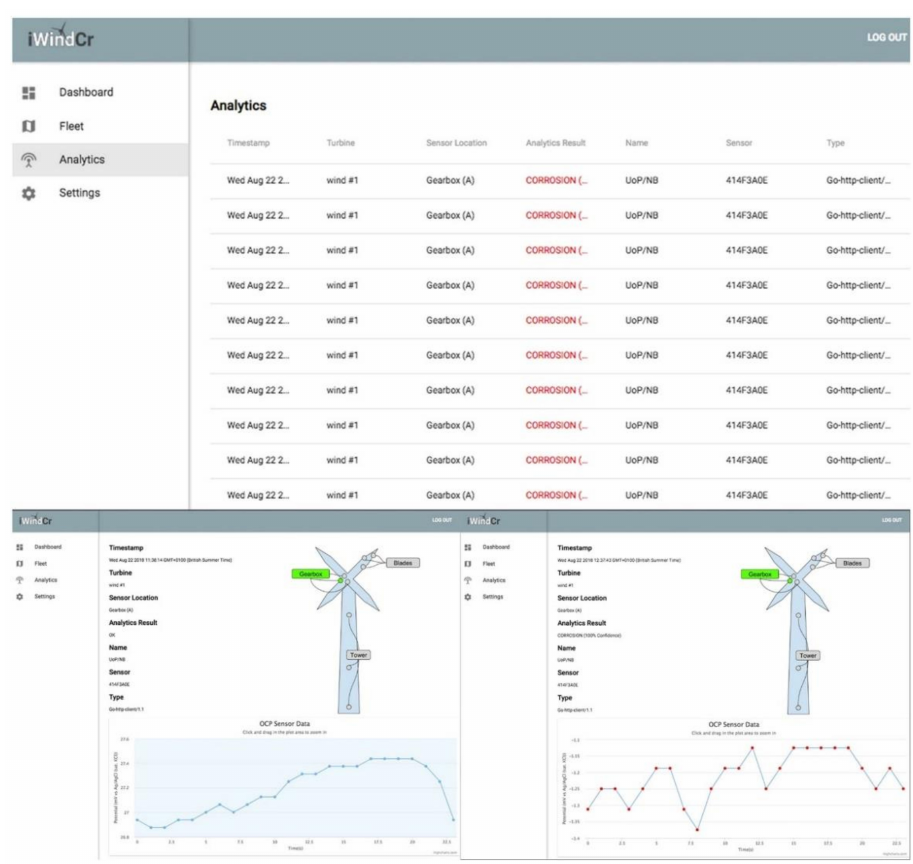
Figure 25. Arrangement plan of the iWindCr WSN system [132].